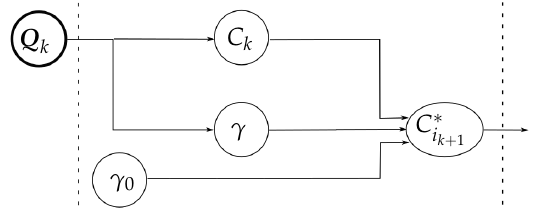
Figure 8. Variables involved in the optimization of the object